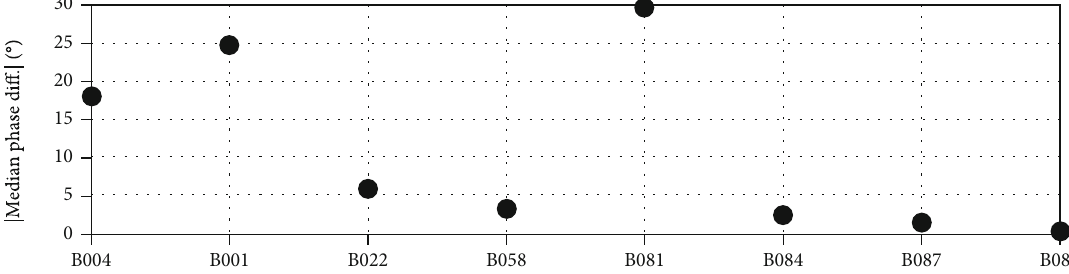
Figure 7: Median phase di ff erence between strainmeter data and modeled strain. Note large di ff erences in boreholes B004 and B001 where there is no local ocean tidal loading model for nearby Puget